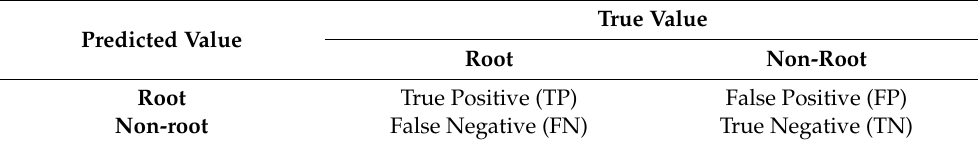
Table 3. Confusion